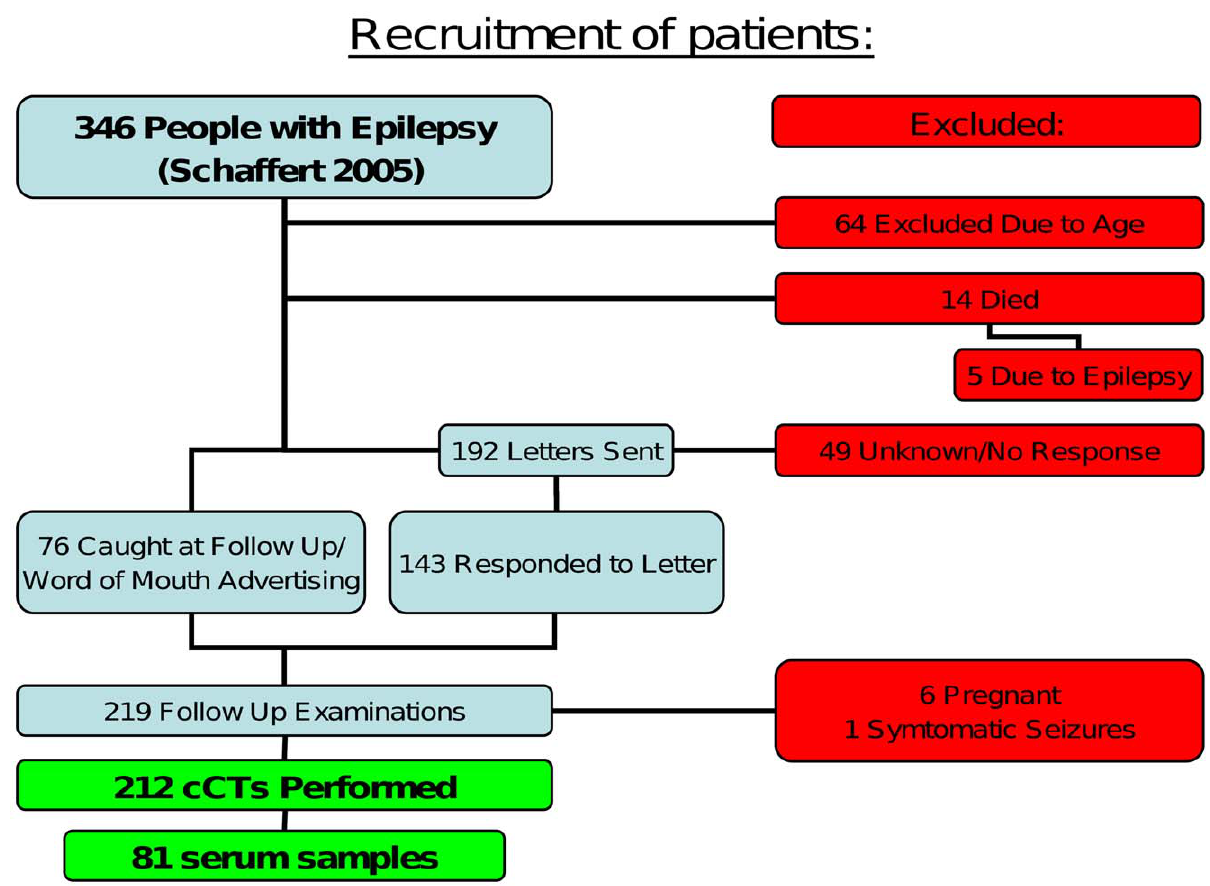
Figure 1. Flow chart for the recruitment of patients. For more details see Methods.